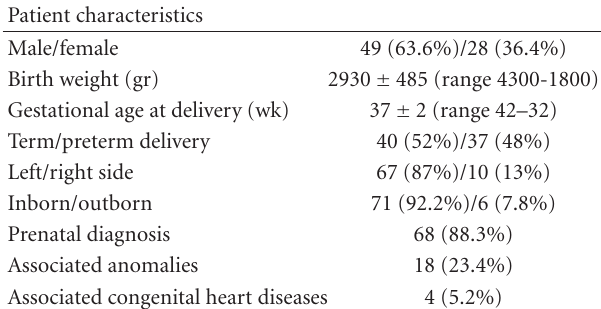
Table 1: Perinatal data of 77 patients a ff ected by